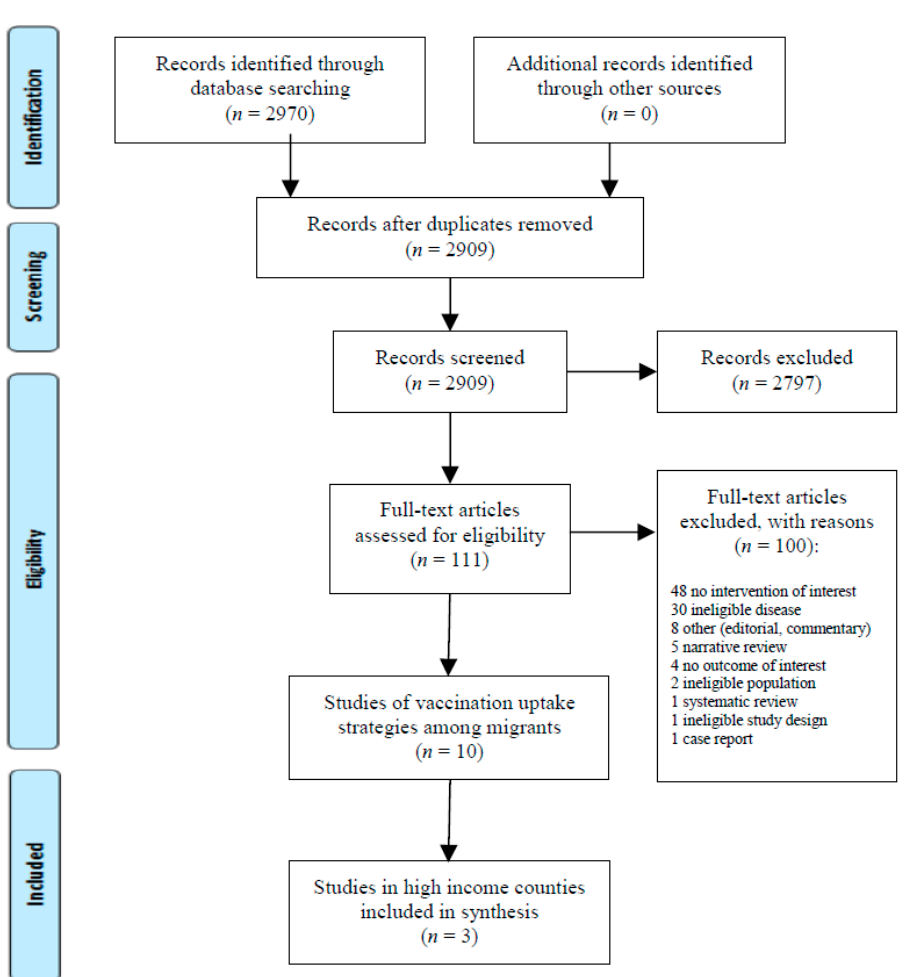
Figure 1. PRISMA Flow Diagram–Interventions to Increase Vaccination Uptake among Migrants.